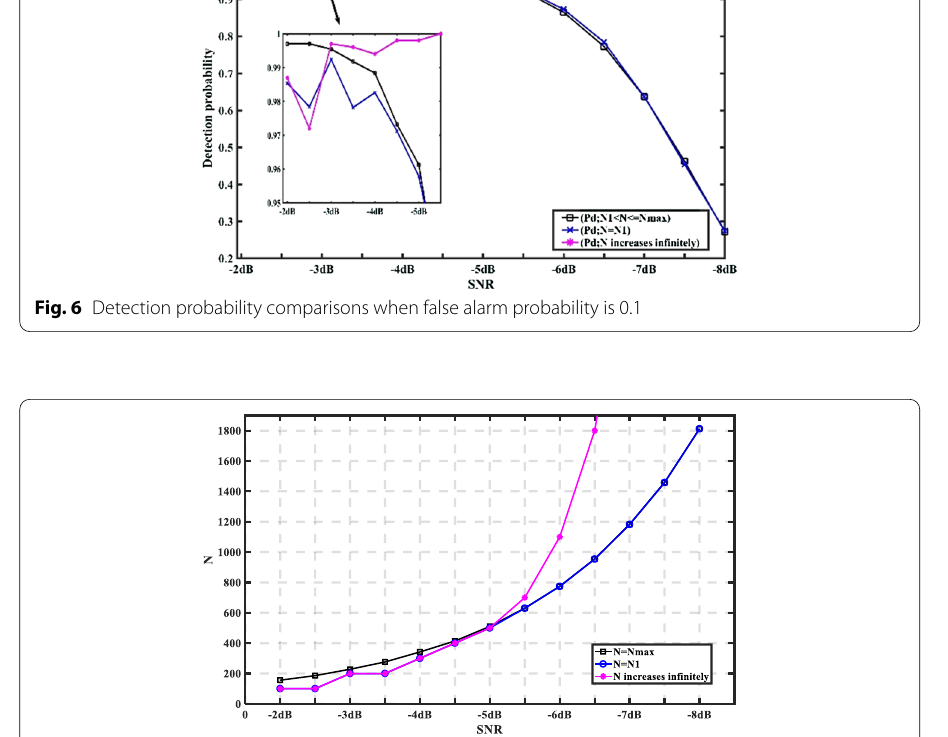
Fig. 7 Variation of the sampling point with